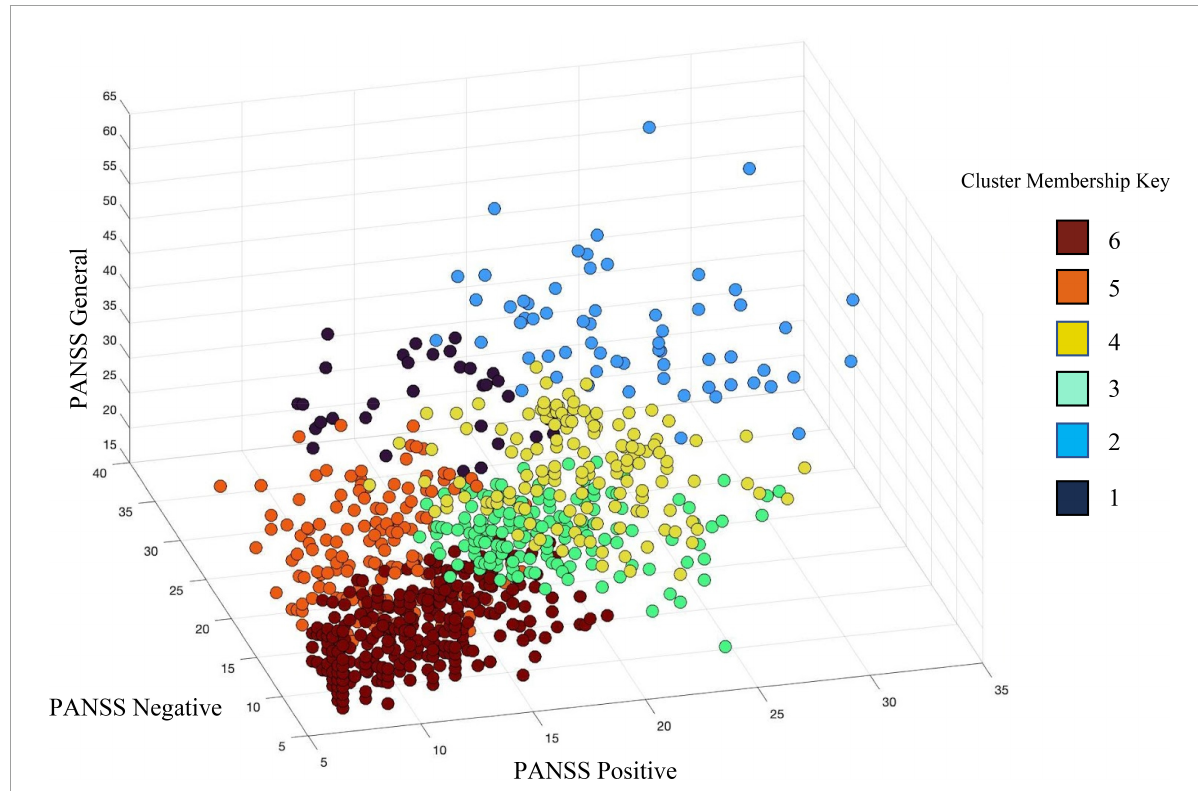
FIGURE4 Hierarchical clustering of PANSS subscale scores identified six (6) clusters across individuals with schizophrenia (SZ) and individuals with bipolar disorder (BP). PANSS positive scores are plotted on the X-axis, PANSS negative scores on the Y-axis, and PANSS general psychopathology scores are on the Z-axis. See legend for cluster membership